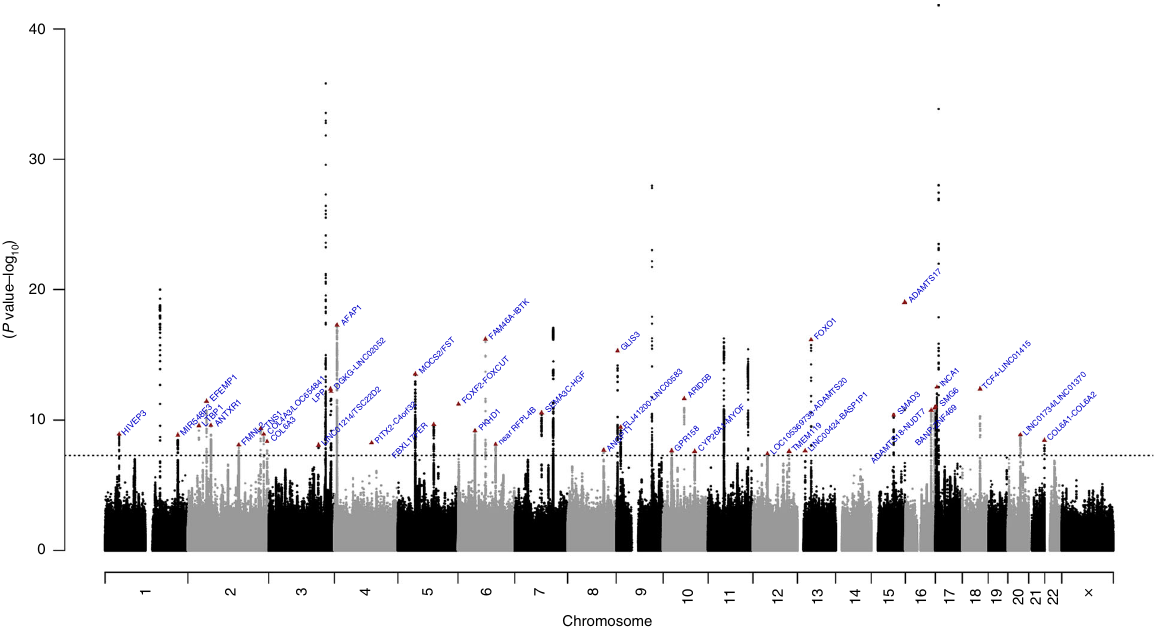
Fig. 2 Manhattan plot of the GERA discovery cohort trans-ethnic GWAS meta-analysis of IOP. GWAS of IOP was conducted in 69,756 individuals from four race/ethnicity groups (non-Hispanic white, Latino, East Asian, and African American). Association results ( – log 10 P values) are plotted for each chromosome. The locus/gene names are indicated for each novel locus associated with IOP, and the lead SNP at each IOP novel loci is represented by a red replicated at a genome-wide level of signi fi cance in our GERA FNDC3B rs6445055, CAV1 rs10258482 and rs423660, ABCA1 rs2472493, ARHGEF12 rs58073046, GAS7 rs9913911 and